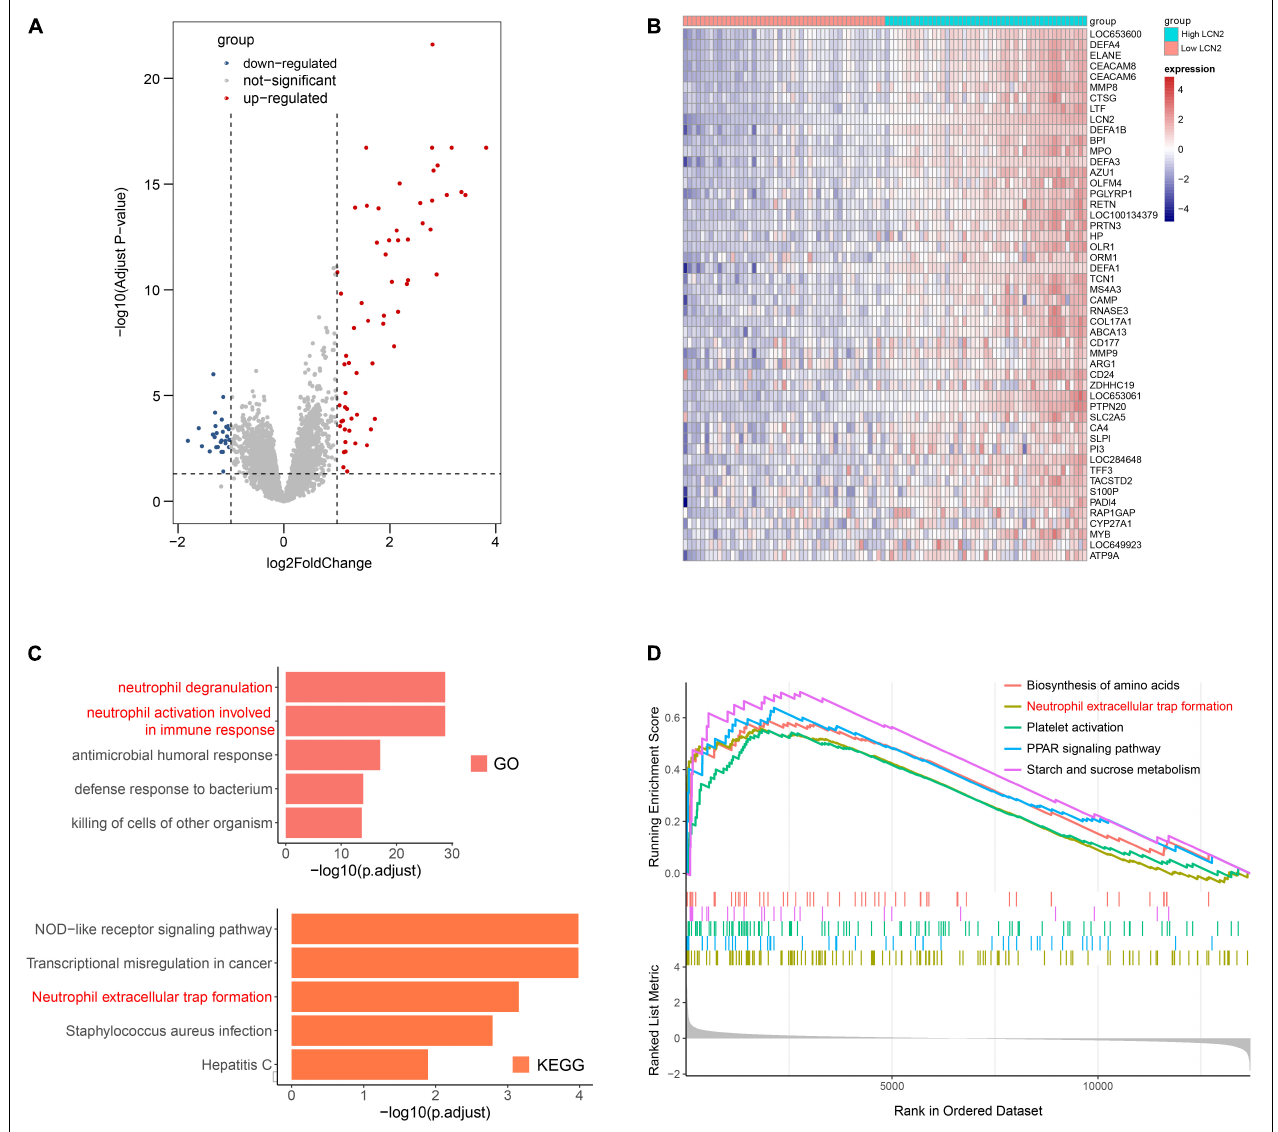
FIGURE 5 | Functional analysis of LCN2 in patients with IAV. (A) DEGs between patients with low LCN2 and high LCN2 with IAV infection (GSE111368). (B) Heatmap of DEGs between patients with low LCN2 and high LCN2 with IAV infection. (C) GO terms and KEGG pathway enrichment analysis of DEGs between patients with low LCN2 and high LCN2 with IAV infection. (D) GSEA in groups with patients with high